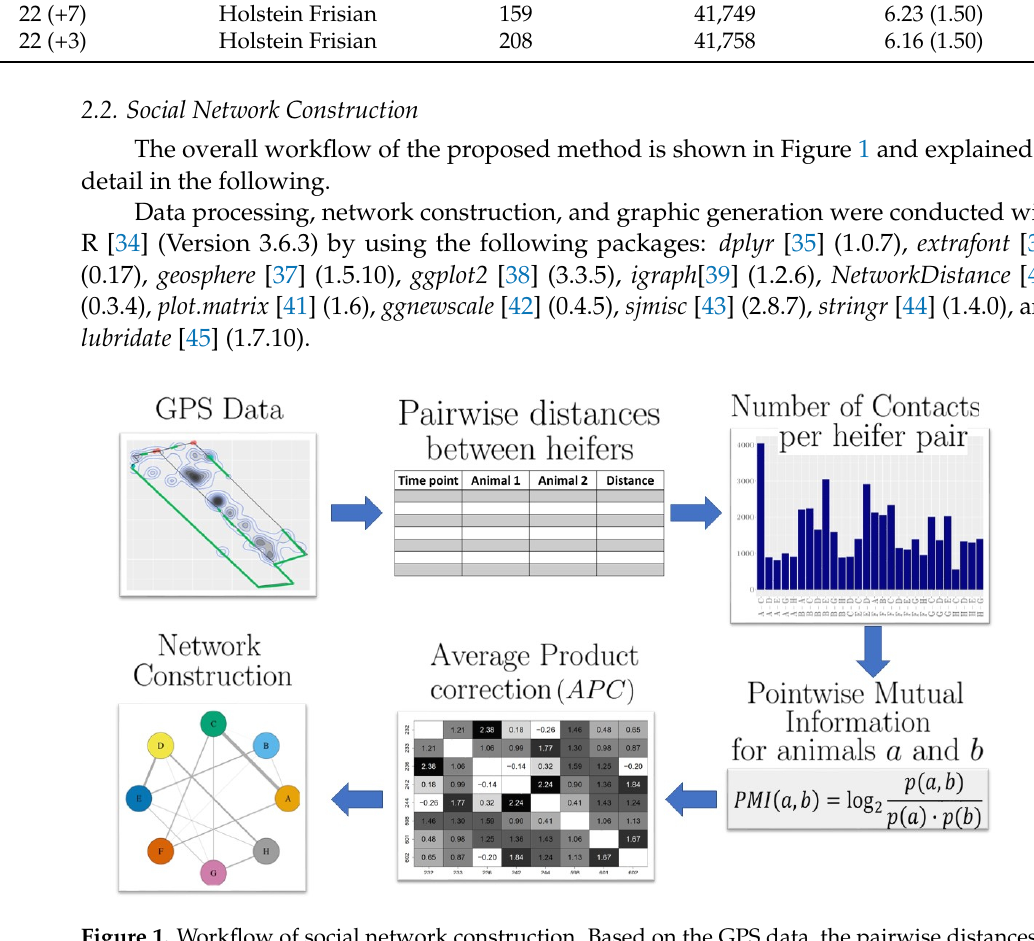
Figure 1. Workflow of social network construction. Based on the GPS data, the pairwise distances at each tracked time point were calculated for all heifer pairs. Based on these distances, all pairwise contacts were counted by using a predefined distance threshold. These numbers of contacts in turn were used to calculate the (positive) pointwise mutual information (PMI), and background co- occurrences of heifers were eliminated by using the average product correction (APC) procedure. Finally, the social network was constructed where edges refer to associations between the heifers, i.e., the corresponding PMI values were > 0 after the APC